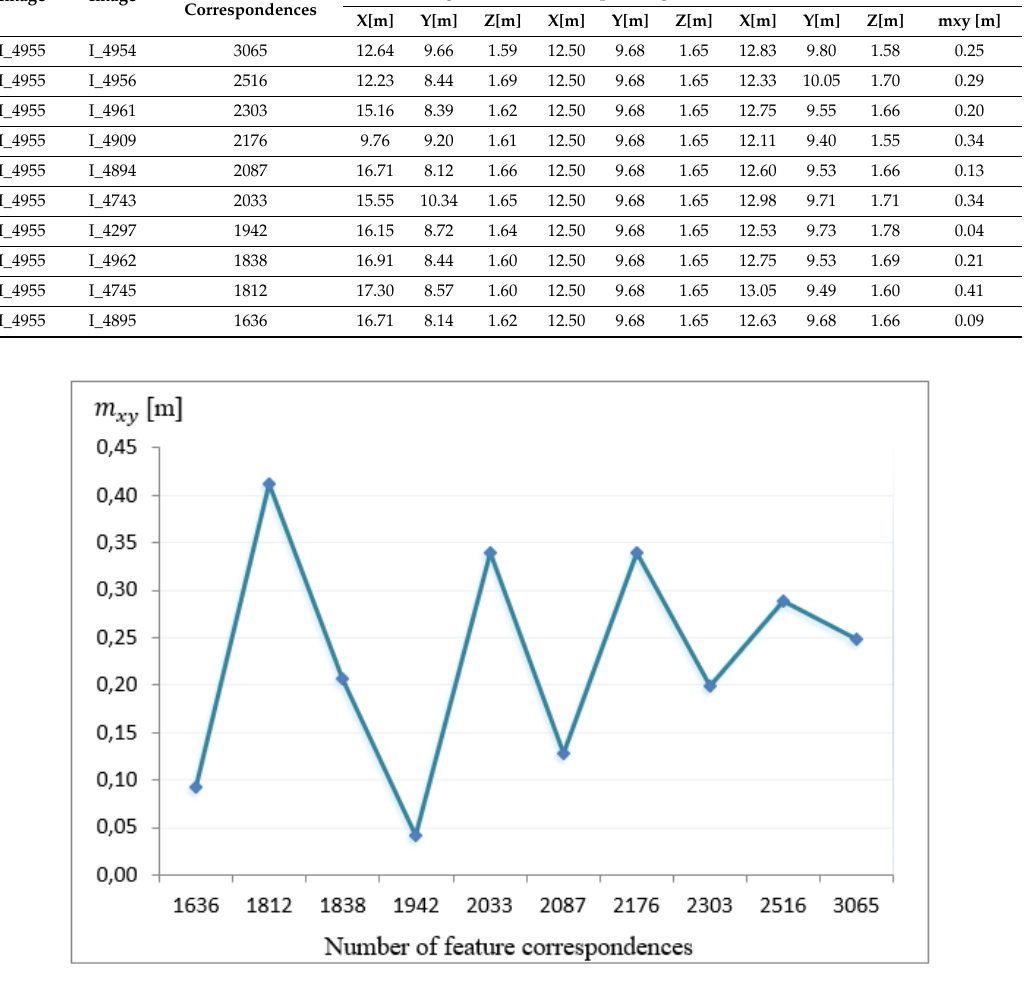
Figure 9. Number of feature correspondences and its dependence on position error Graph 2. Number of feature correspondences and its dependence on position error [39].